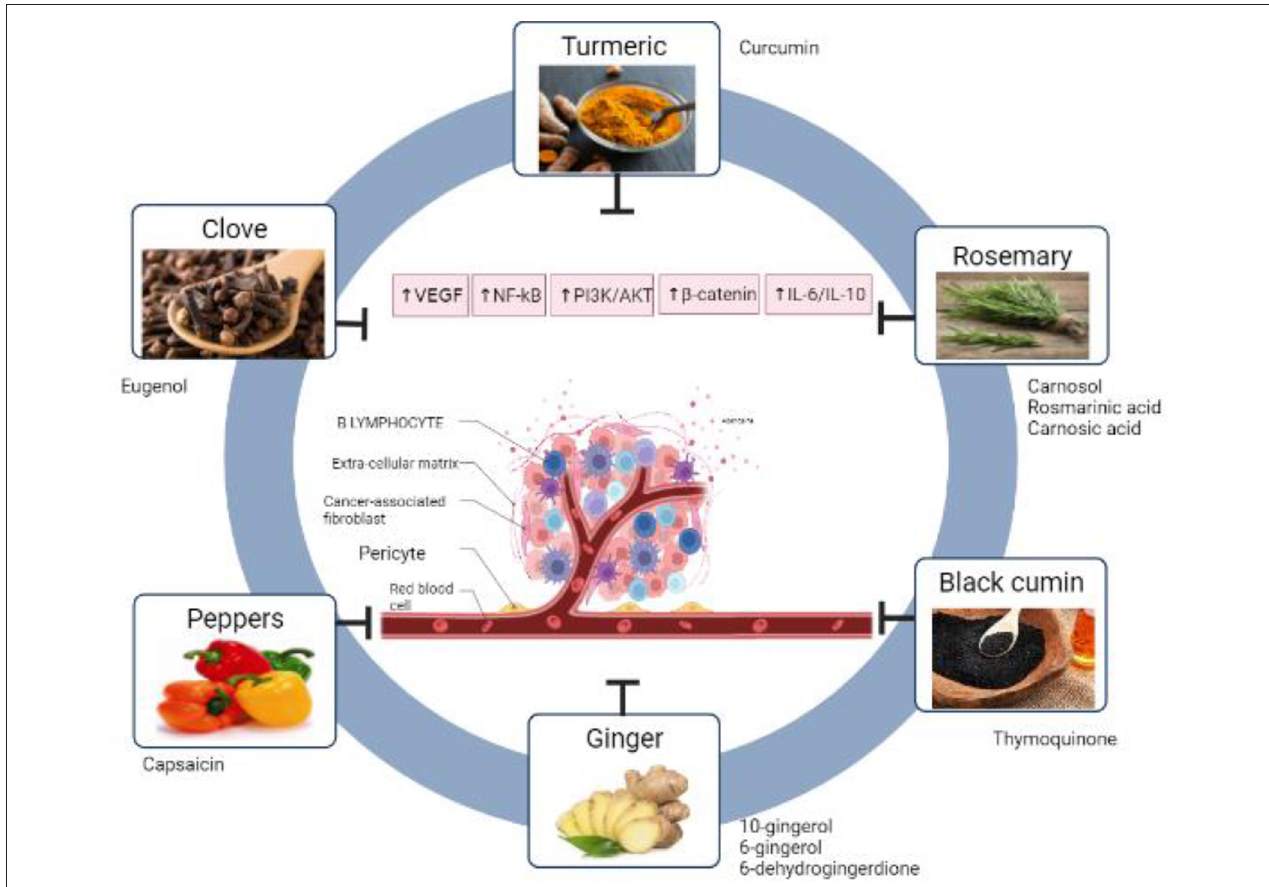
FIGURE 7 | The main Mediterranean diet spices and their